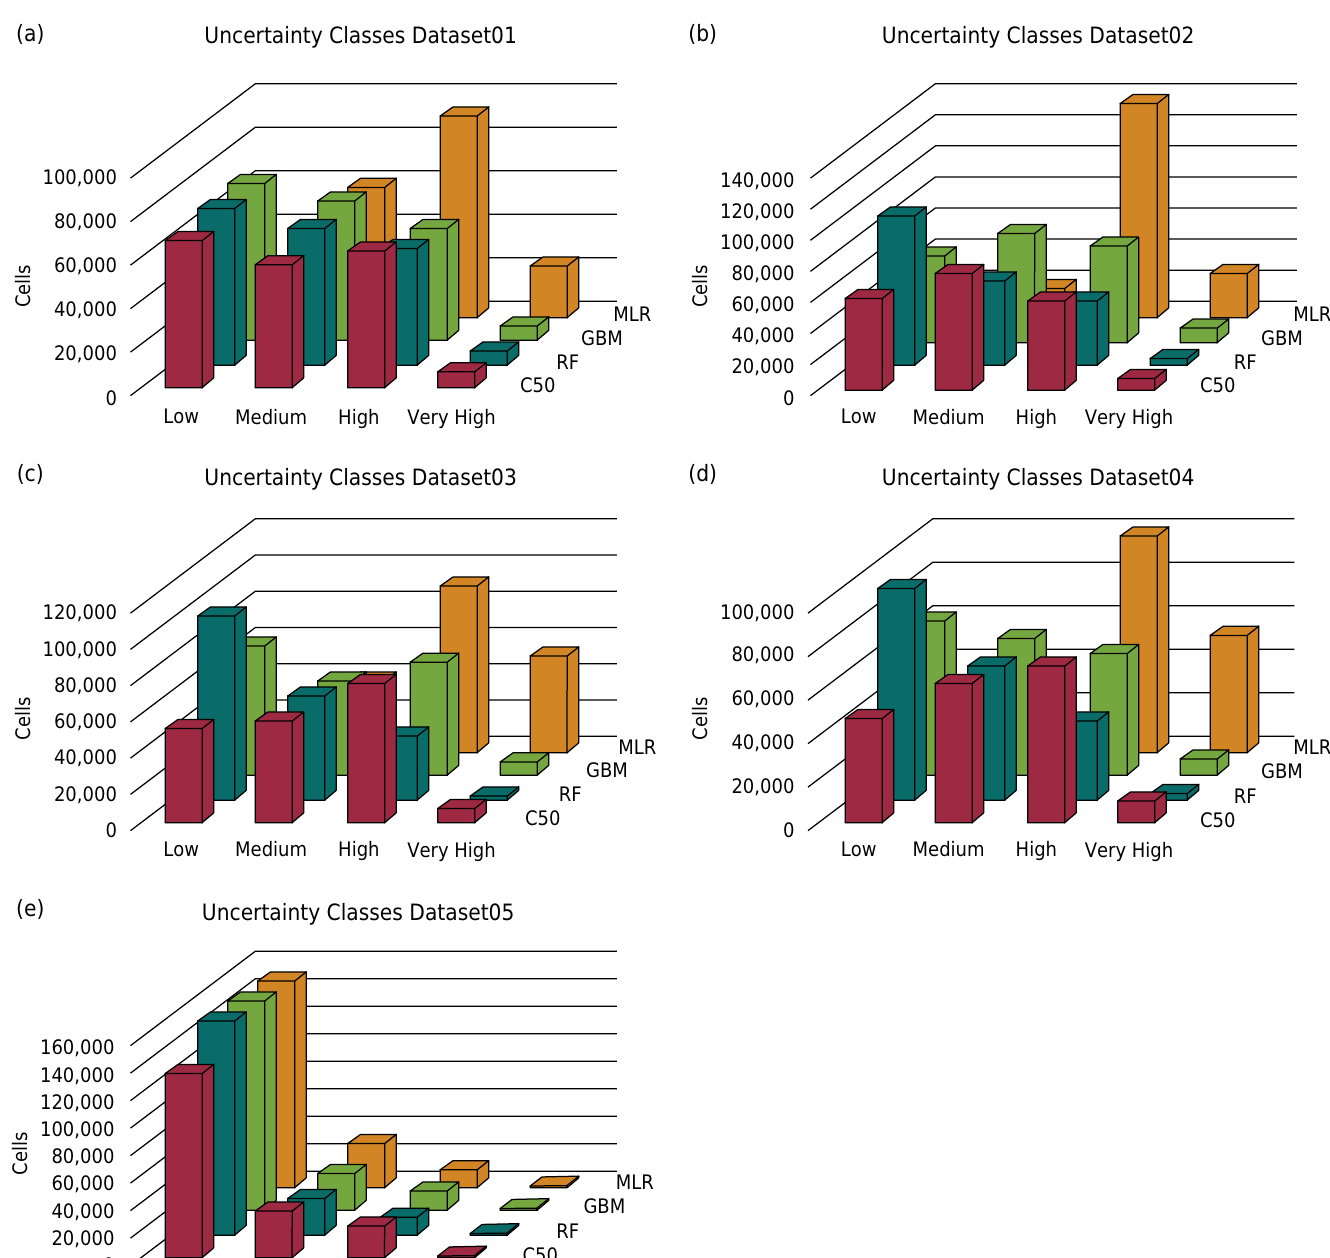
Figure 7. Graphical distribution of uncertainty classes by dataset and model, where Low (≤0.2); Medium (>0.2 to ≤0.4); High (>0.4 to ≤0.6) and Very High